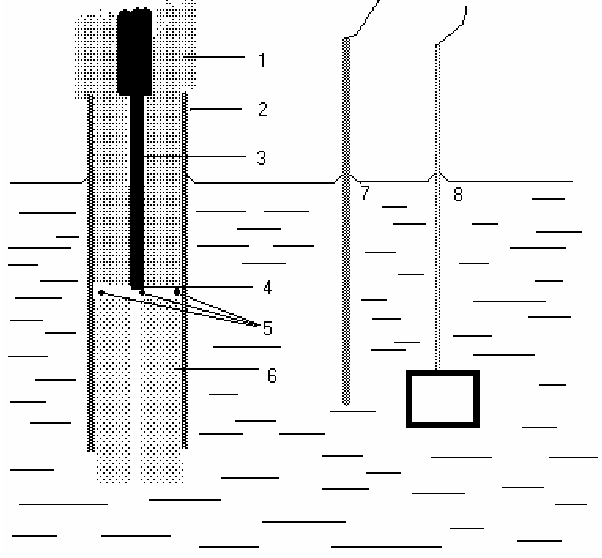
Figure 3. Scheme of HPLC detector with AgSAE electrode: 1) glass, 2) plastic tube, 3) silver amalgam, 4) mercury meniscus, 5) holes, 6) Teflon tube-outlet of HPLC, 7) reference electrode, 8) auxiliary